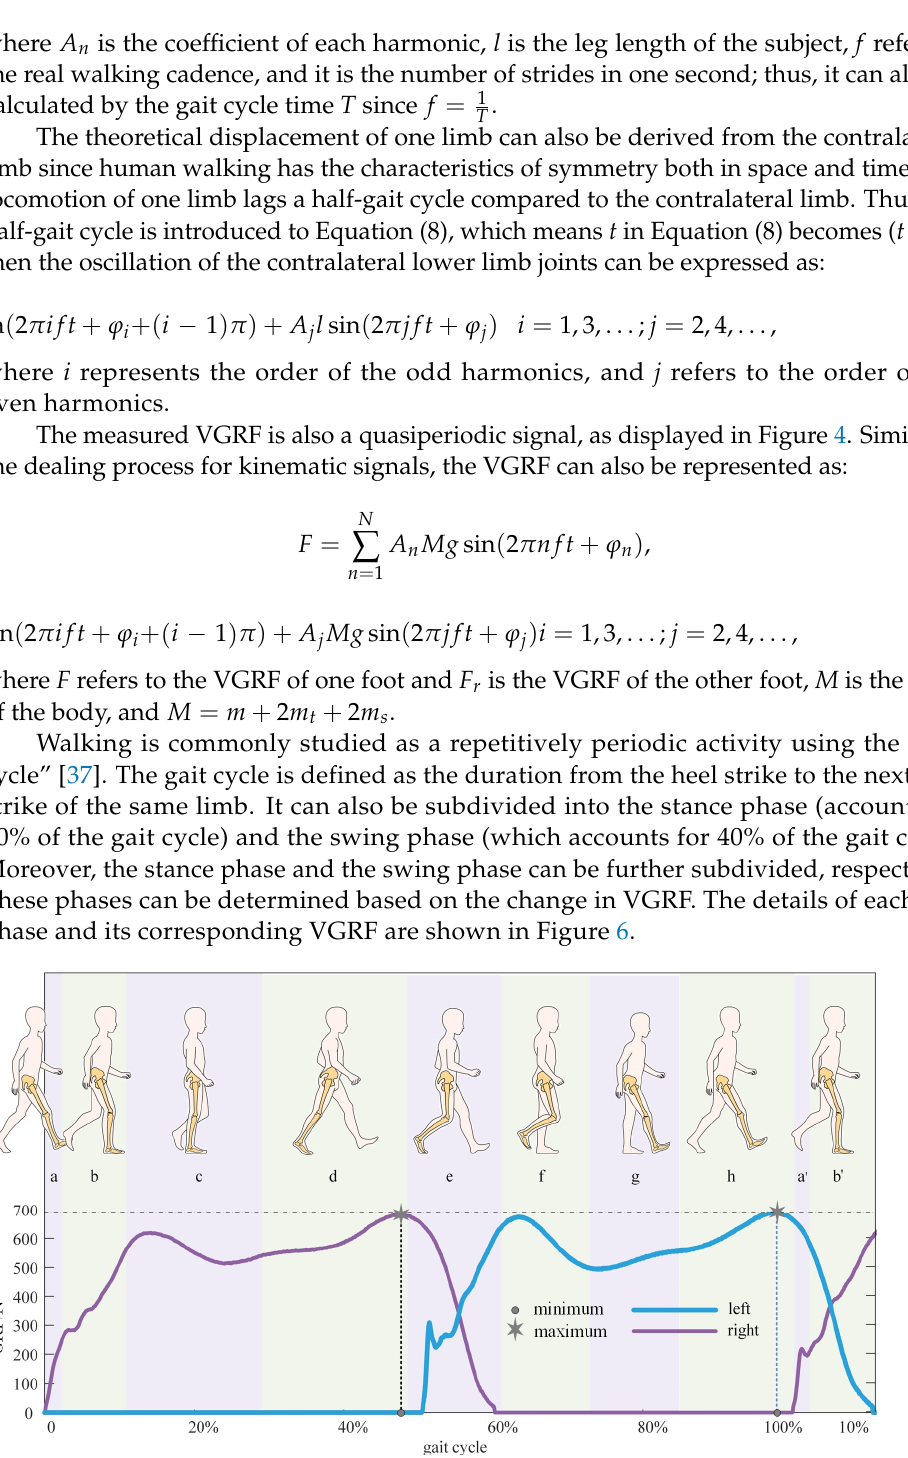
Figure 6. Gait cycles and corresponding ground reaction force. ( a ) Initial contact when heel strike, and it accounts for 2% gait cycle; ( b ) loading response that means foot flatting, and it accounts for 10% gait cycle; ( c ) midstance, and it accounts for 17% gait cycle; ( d ) terminal stance when heeling off, and it accounts for 19% gait cycle; ( e ) pre swing means toe-off, and it accounts for 12% gait cycle; ( f ) initial swing, and it accounts for 13% gait cycle; ( g ) mid swing, and it accounts for 12% gait cycle; and ( h ) terminal swing, and it accounts for 13% gait cycle; ( a’ ) and ( b’ ) are phases in the next gait cycle and their determination are the same as ( a ) and ( b ) respectively.